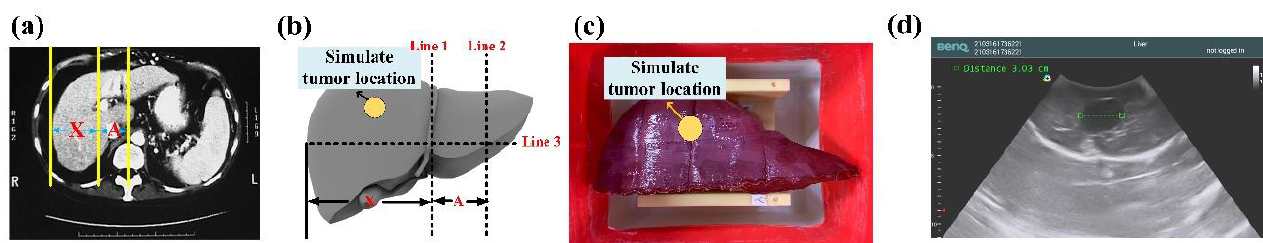
Figure 11. ( a ) Abdominal cavity phantom CT image; ( b ) 3D modeling by measuring method for liver on a CT image; ( c ) stereogram of the gel-prepared phantom; ( d ) phantom ultrasonic image and tumor location.